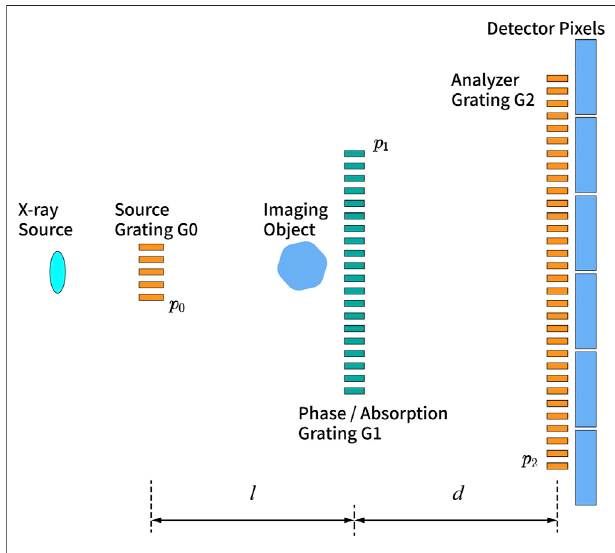
FIGURE 1 | Schematic of grating-based X-ray imaging